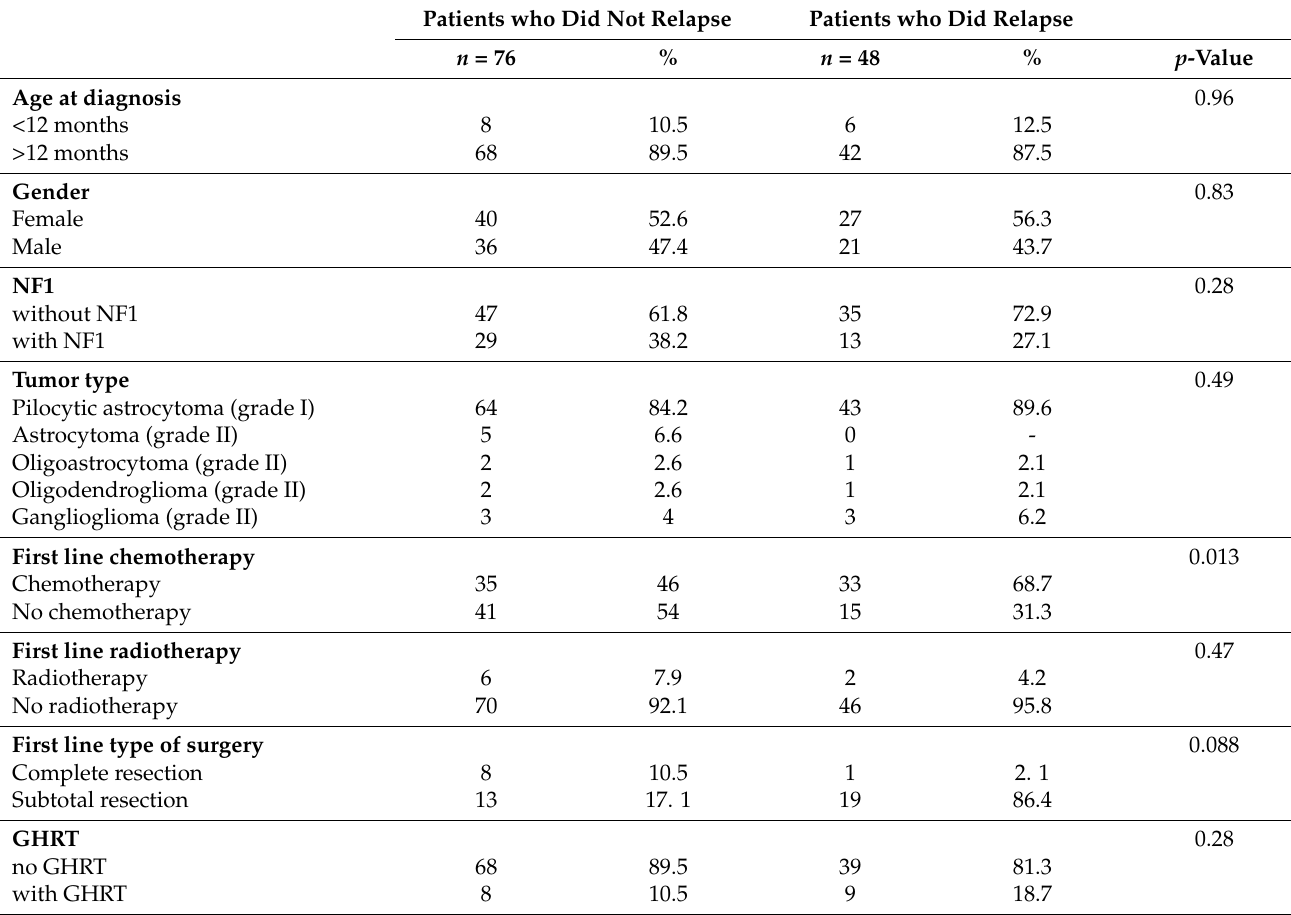
Table 4. The impact of different factors on relapse in patients treated for midline glioma in Lille and Lyon between 1 January 1998 and 31 December, 2016 (univariable analysis).